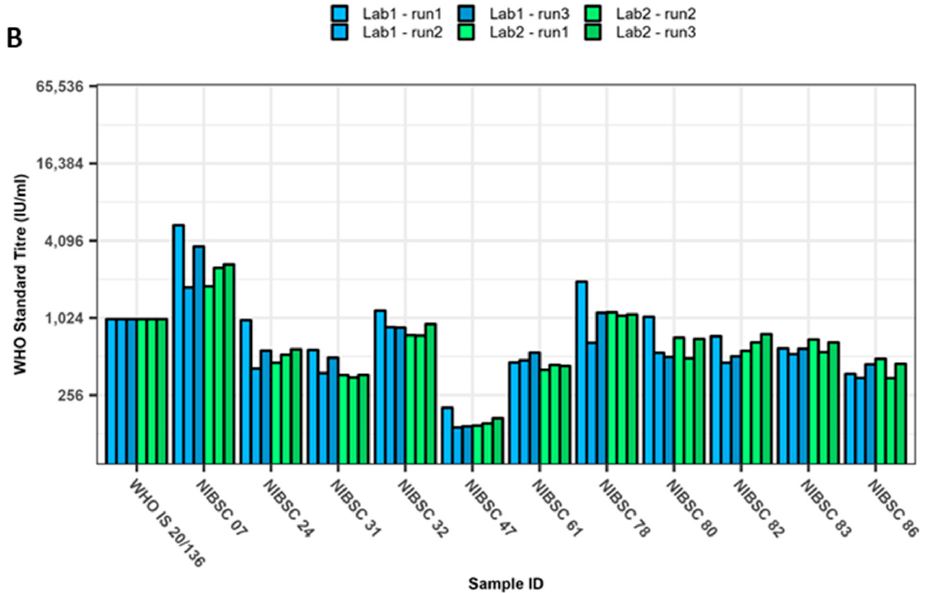
Figure 3. Comparison of the effect of using the WHO International Standard (IS) 20/136 for normalisa- tion between labs. A panel of 11 pre-Alpha convalescent plasma and the WHO IS 20/136 were assessed for their neutralising capacity against authentic ancestral SARS-CoV-2 using a FRNT assay. Neutralising titres are presented as ( A ) ND 50 or ( B ) IU/mL with normalisation to the WHO IS 20/136.